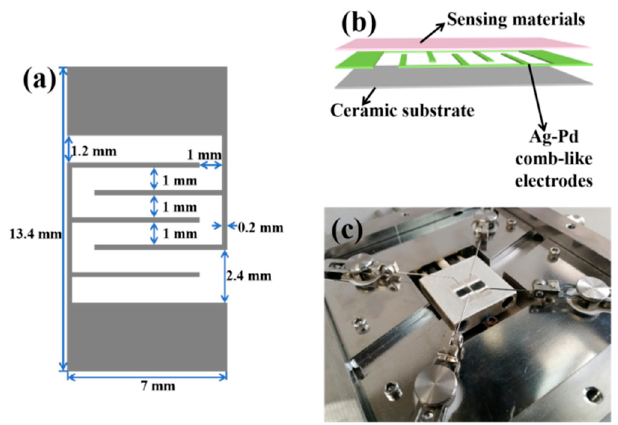
Figure 1. Schematic structure of the blank sensor ( a ) and the fabricated sensor ( b ). ( c ) The test chamber of the gas sensing equipment.